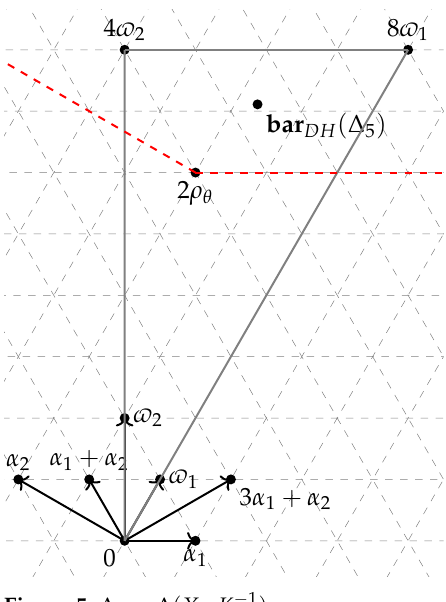
Figure 5. ∆ 5 = ∆ ( X 5 , K − 1